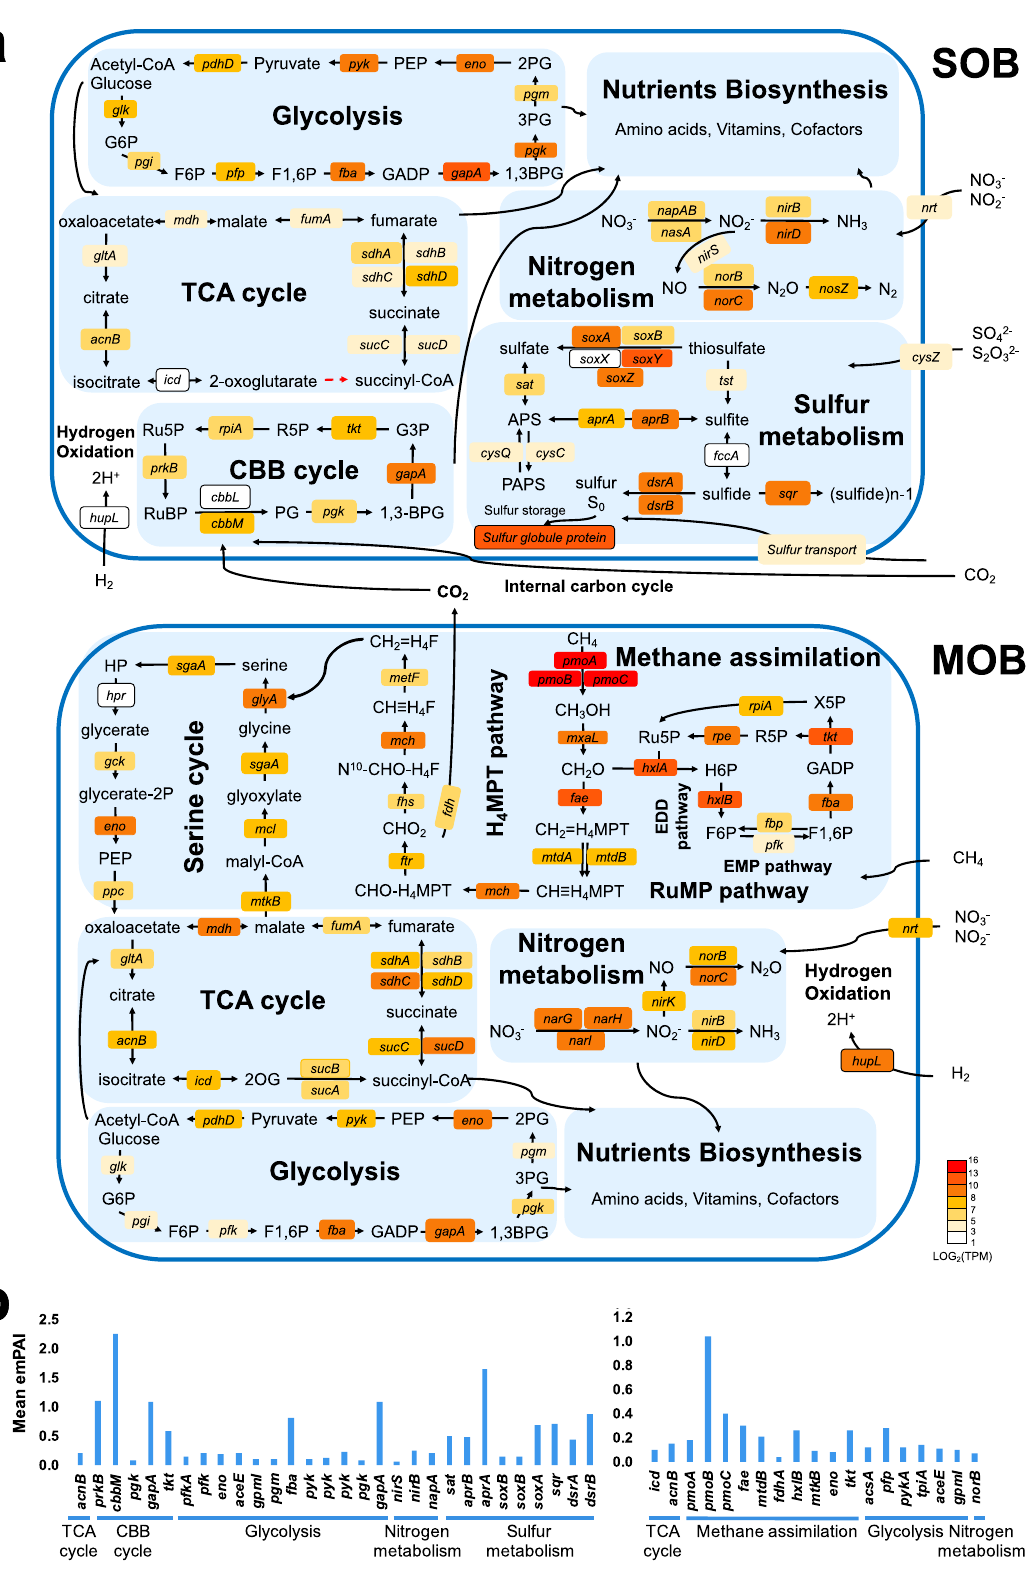
Fig. 8 Central metabolism of the dual symbionts of Gigantopelta aegis . a Central metabolism pathways in the sulfur-oxidising endosymbiont (SOB) and the methane-oxidising endosymbiont (MOB). The boxes represent genes involved in the respective process, and they are colour coded according to the log-transformed normalised transcripts per kilobase million (TPM) value ( n = 3) showing the gene expression level in metatranscriptome analysis (colour from red to light white represents high expression level to low expression level; dash arrow indicates that the gene is missing in the genome). b Protein abundances involved in the central metabolism of the SOB (left) and the MOB (right). Protein abundances are reported as mean emPAI values ( n = 3) assessed in metaproteome analysis; n means biologically independent animals. The description of abbreviations are provided in Supplementary Note